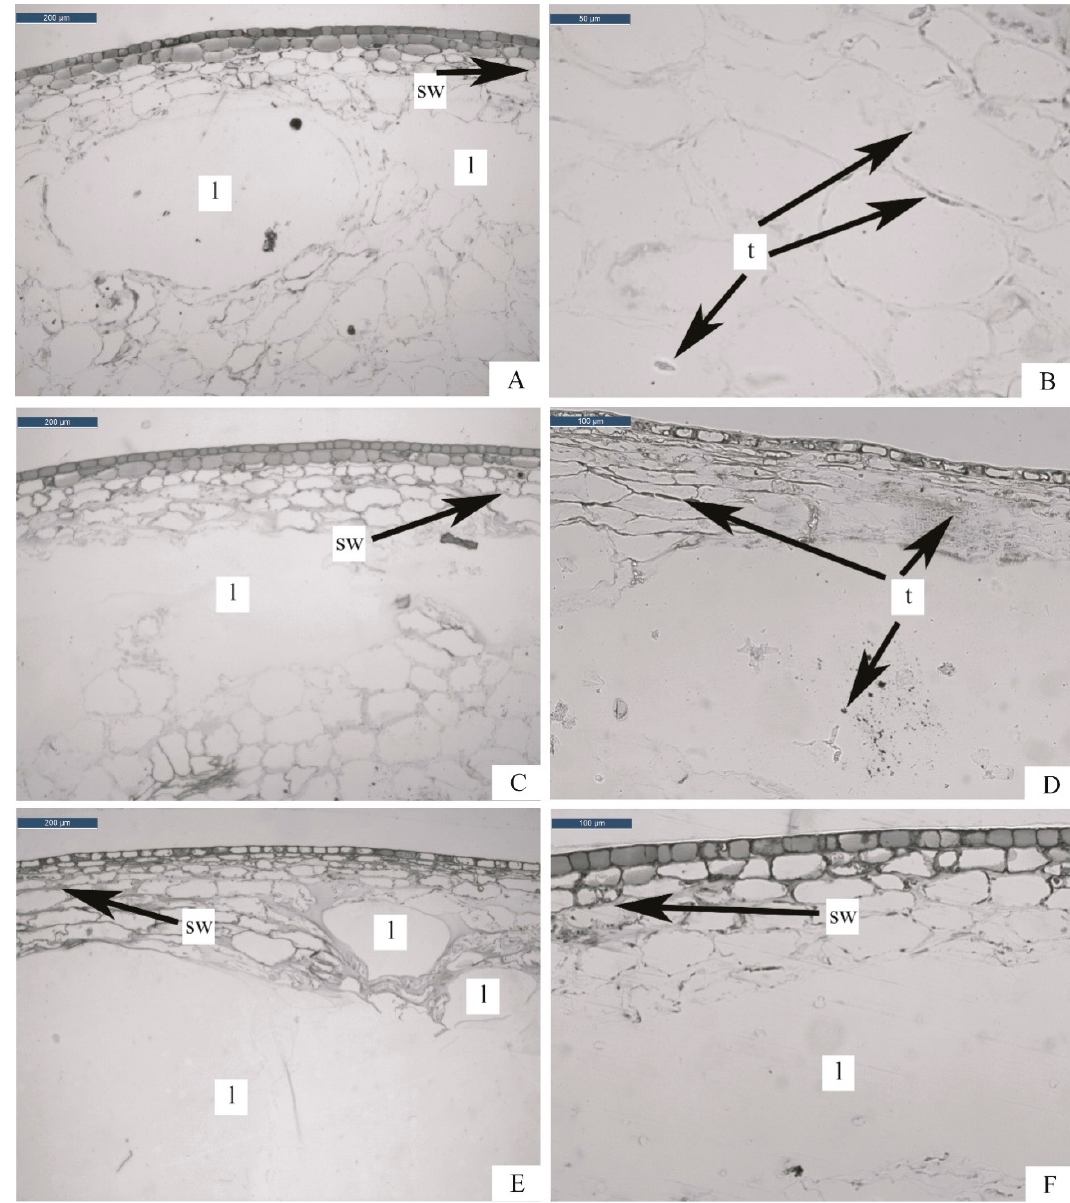
Figure 2. Transverse sections of blueberries samples treated using HHP technology: ( A ) 400-1 stained with Toluidine Blue (TBO); ( B ) 400-1 stained with tannin solution; ( C ) 400-5 stained with Toluidine Blue (TBO); ( D ) 400-5 stained with tannin solution; ( E ) 600-1 stained with Toluidine Blue (TBO); ( F ) 600-5 stained with Toluidine Blue (TBO). Abbreviations: l = lacuna; sw = swelling; t = tannins.